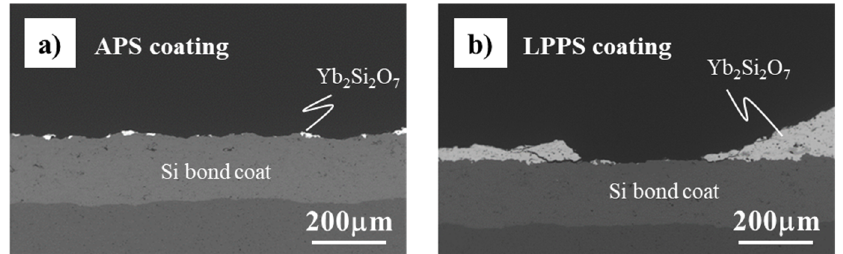
Figure 3. Cross-section microstructures after bonding strength test for ( a ) APS and ( b ) LPPS Yb 2 Si 2 O 7 /Si EBCs.